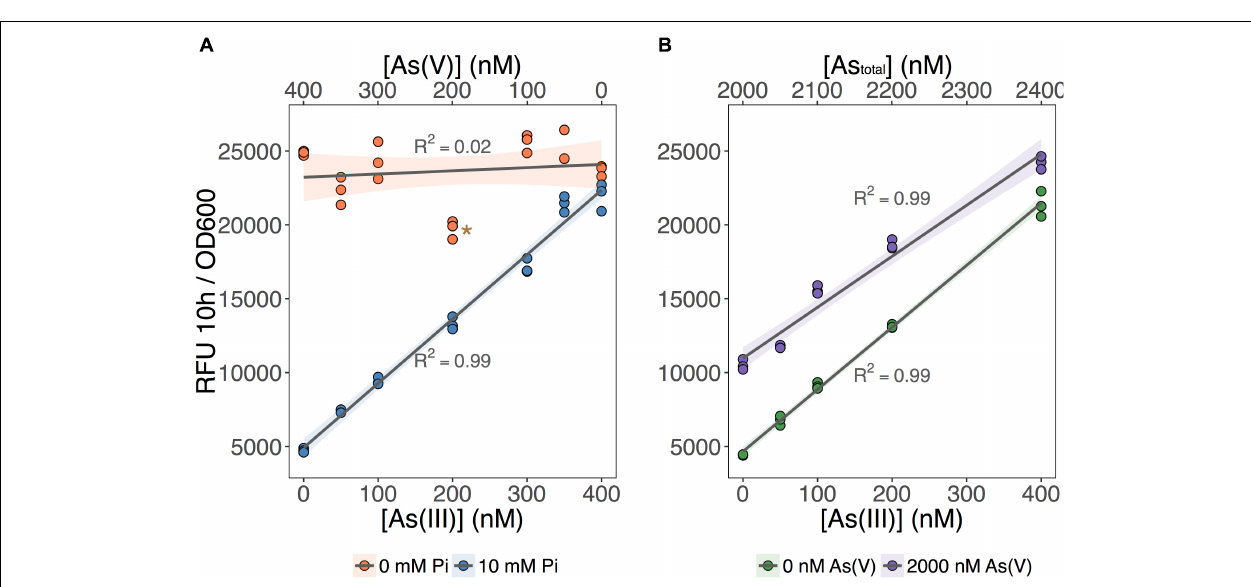
FIGURE 2 | Effect of major ions on arsenic species detection. Detection of As(III) and As(V) in MGP exposure medium supplemented with NaCl, inorganic phosphate (Pi), CaCl 2 , or MgCl 2 . Pi was supplemented as a mixture of sodium/potassium phosphate salts ( Supplementary Table S1 ). The arsenic concentration was 400 nM in each treatment. The mean and standard deviation of RFU per OD 600 after 18 h of growth is presented for triplicate samples. Left panel, no significant differences were observed between linear regressions of As(III) and As(V) output signal over the NaCl concentration gradient ( p = 0.07). In conjunction with ANOVAs, TukeyHSD was used for calcium, magnesium, and phosphate treatments. Stars indicate a statistically significant difference in output signals when compared to the control (dotted line; no added ions).